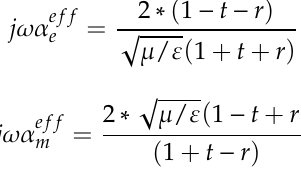
Figure 2. Design of meta-atoms. ( a ) Transmittance for nanoblocks on silica substrate as function of nanoblocks’ width W and length L with H = 132 nm and P = max(W,L) + 90 nm. ( b ) Corresponding phase variation of transmitted light through nanoblocks. ( c ) The highest transmittance achieved by